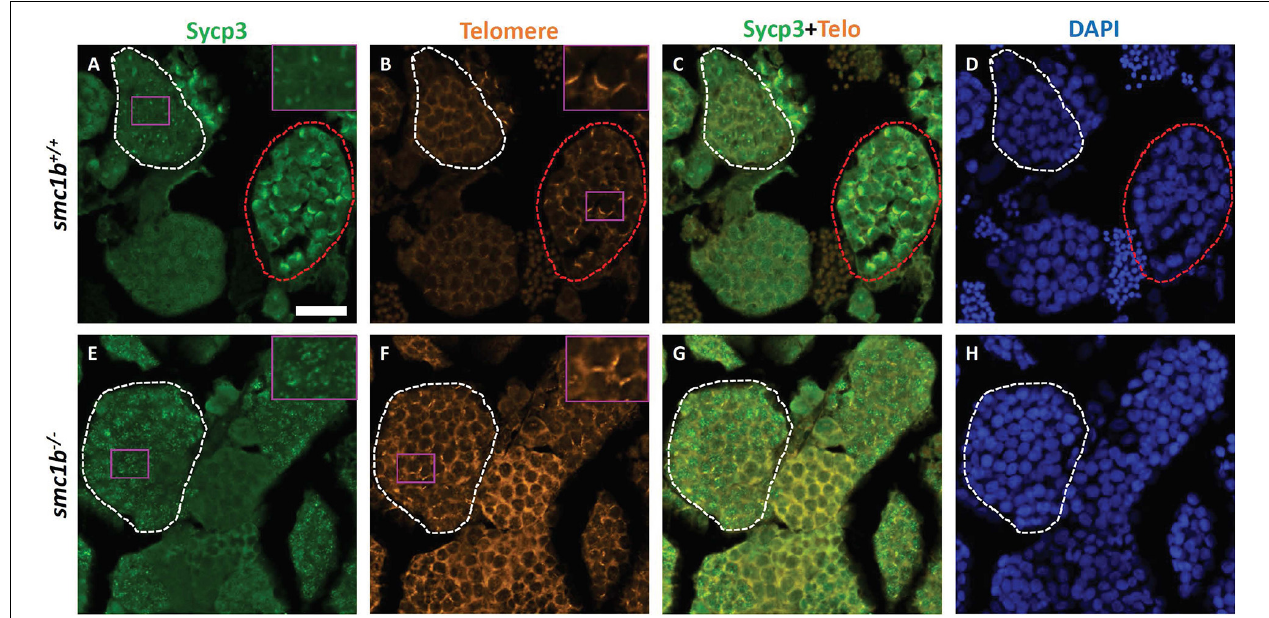
FIGURE 4 | Spermatocytes in smc1b Q198X mutants failed to progress beyond the leptotene stage. Labeling of Sycp3 and telomeres in adult wild-type and mutant testes sections: Sycp3 (green), telomere in situ hybridization (orange), DAPI nuclear stain (blue). (A–H) Leptotene stage spermatocytes are present in both wild-type and mutant spermatocytes, examples circled in white. Bouquet stage cells (circled red) are present in wild type but not in the mutant, however, partial telomere clustering is apparent in some mutant cells [e.g., panel (F) , inset]. Insets are zoomed images of the areas boxed in purple. Scale bar is 20 µ